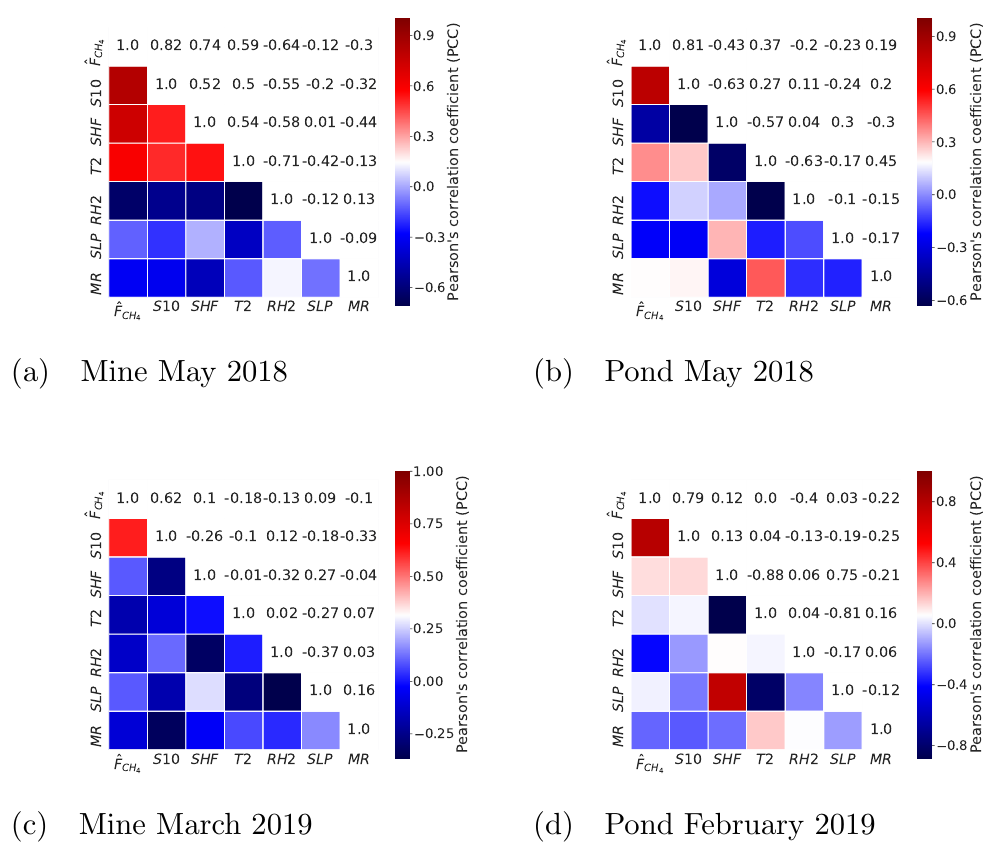
Figure 4. Pearson’s Correlation Coefficient ( PCC ) of near-surface-level Mixing Ratio of methane ( MR ), normalized advective flux ( ˆ F CH ), wind speed at 10 m ( S 10), upward surface Sensible Heat Flux ( SHF ), 4 temperature at 2 m ( T 2), Relative Humidity at 2 m ( RH 2), and Sea Level Pressure ( SLP ); all data except MR used here were from WRF simulations; MR data were from the LGR observations; ( a ) Mine